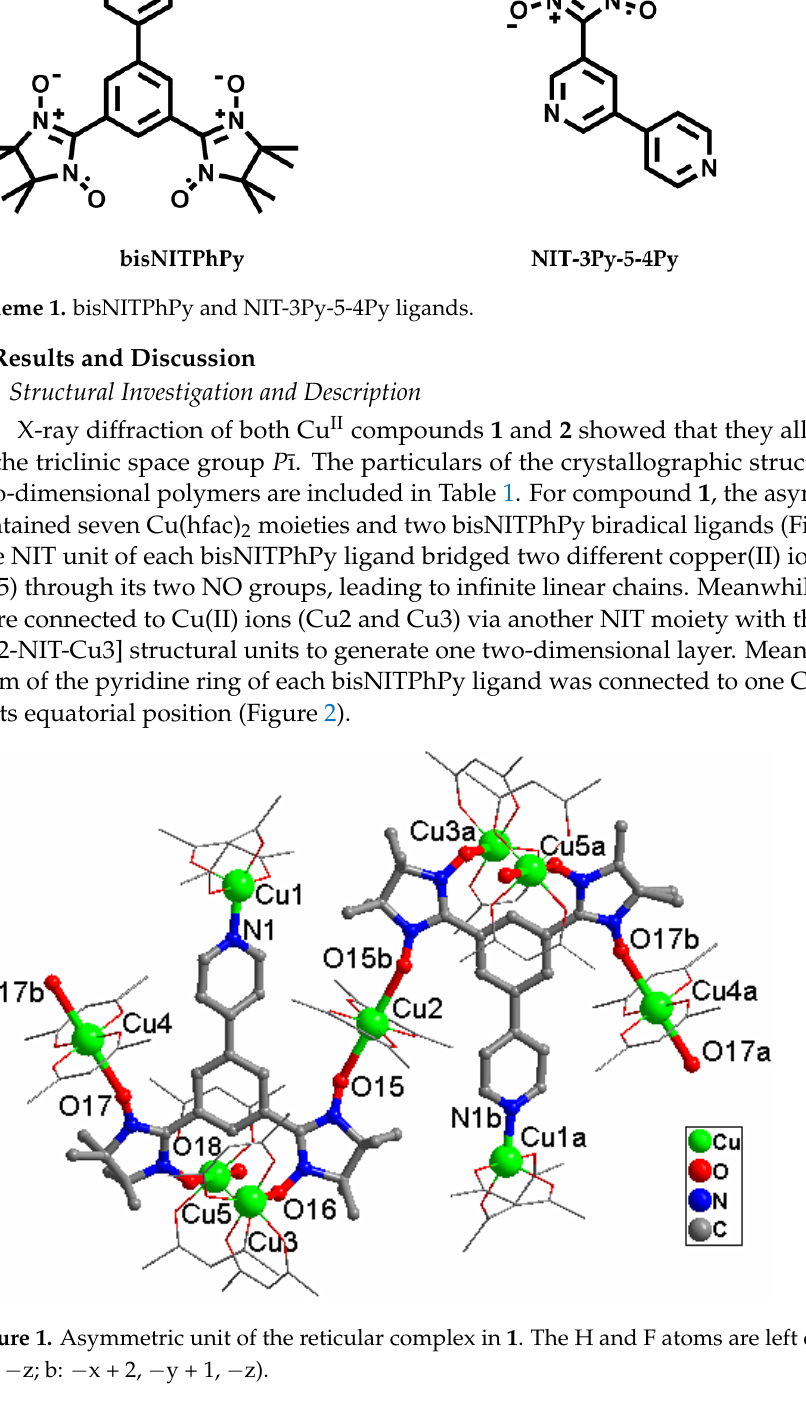
Figure 2. Network structure of compound 1 . The H atoms and bidentate hfac − ligands are deleted.